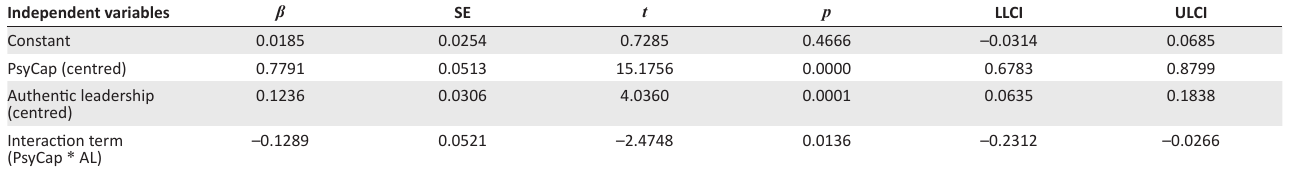
TABLE 2: Moderation analysis with psychological capital as moderator ( N = 647) and work engagement as dependent variable. Independent